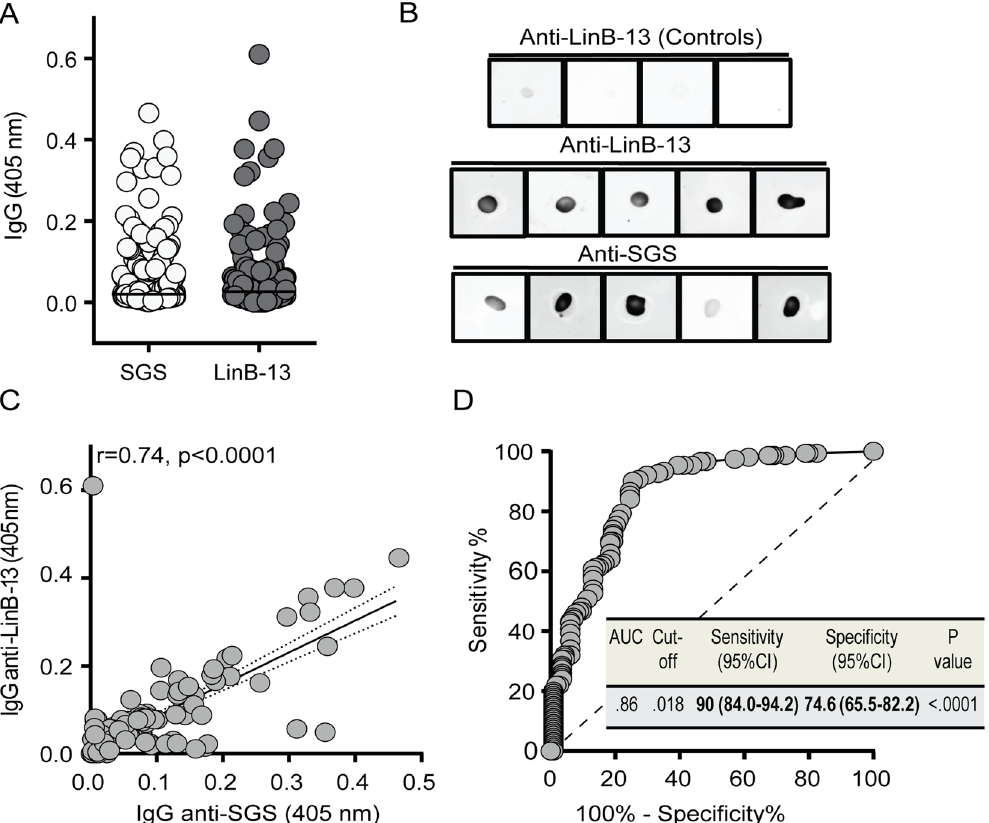
Figure 3. Validation of LinB-13 as a vector exposure maker in an area of L. braziliensis transmission. ( A ) Total IgG response against Lu. intermedia SGS and LinB-13 was measured by ELISA in household contacts (n = 264) of CL patients. Black lines represent the median OD value for each antigen. ( B ) Dot blot analysis against Lu. intermedia SGS and LinB-13 using serum samples from subjects with positive serology to SGS and to LinB- 13 (n = 5) and from controls with negative serology (n = 4). ( C ) Spearman correlation between IgG to Lu. intermedia SGS and LinB-13 in the same individuals represented in ( A ). ( D ) ROC antibody threshold levels predicting positivity to LinB-13 and accompanying detailed information. Data are shown individually.